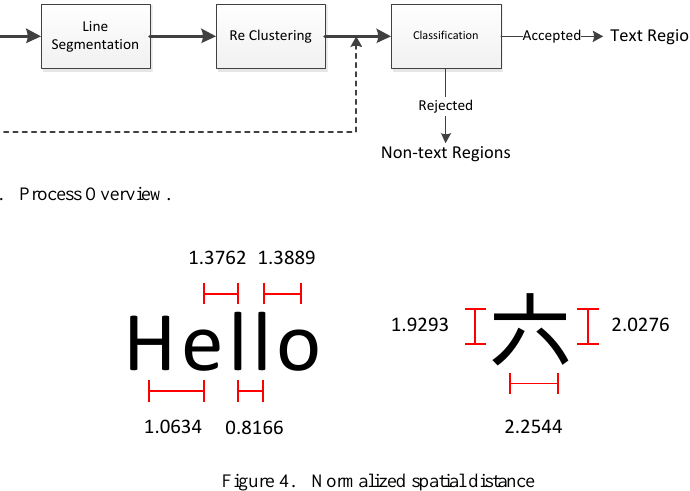
Figure 4. Normalized spatial